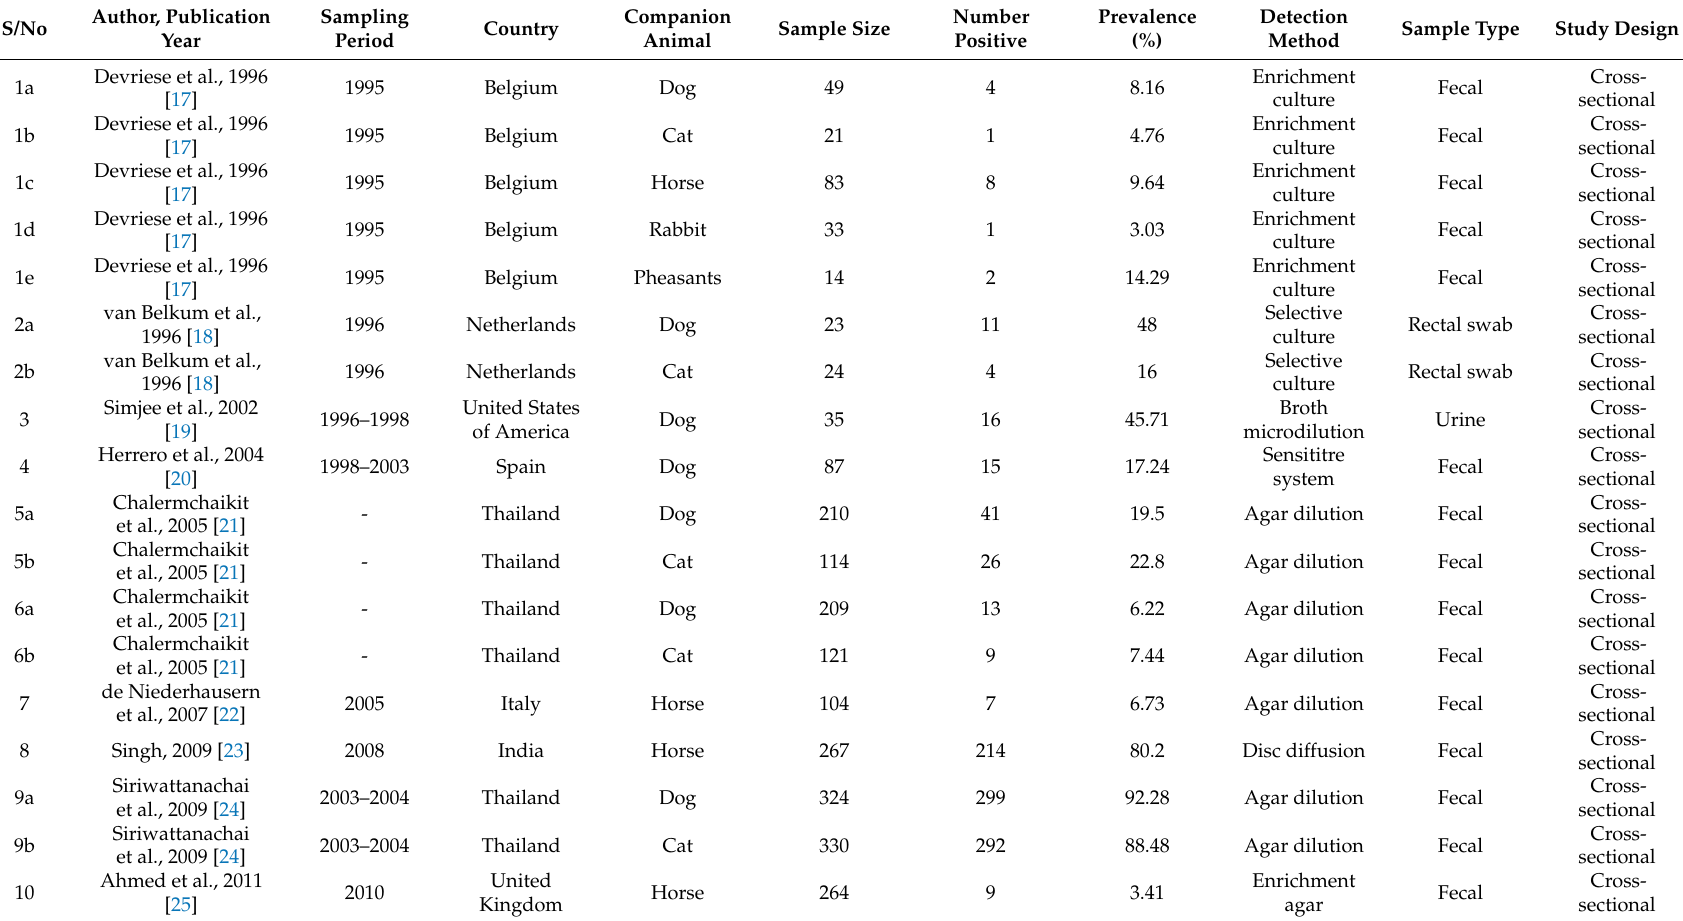
Table 1. Characteristics of included studies reporting the prevalence of vancomycin-resistant Enterococcus (VRE) in companion